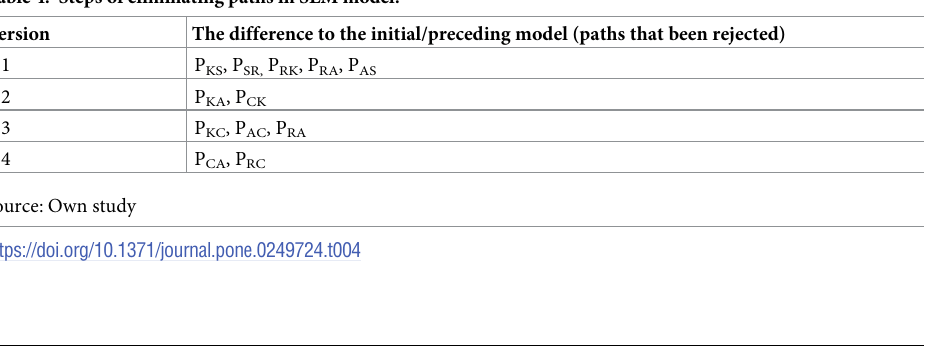
Table 4. Steps of eliminating paths in SEM